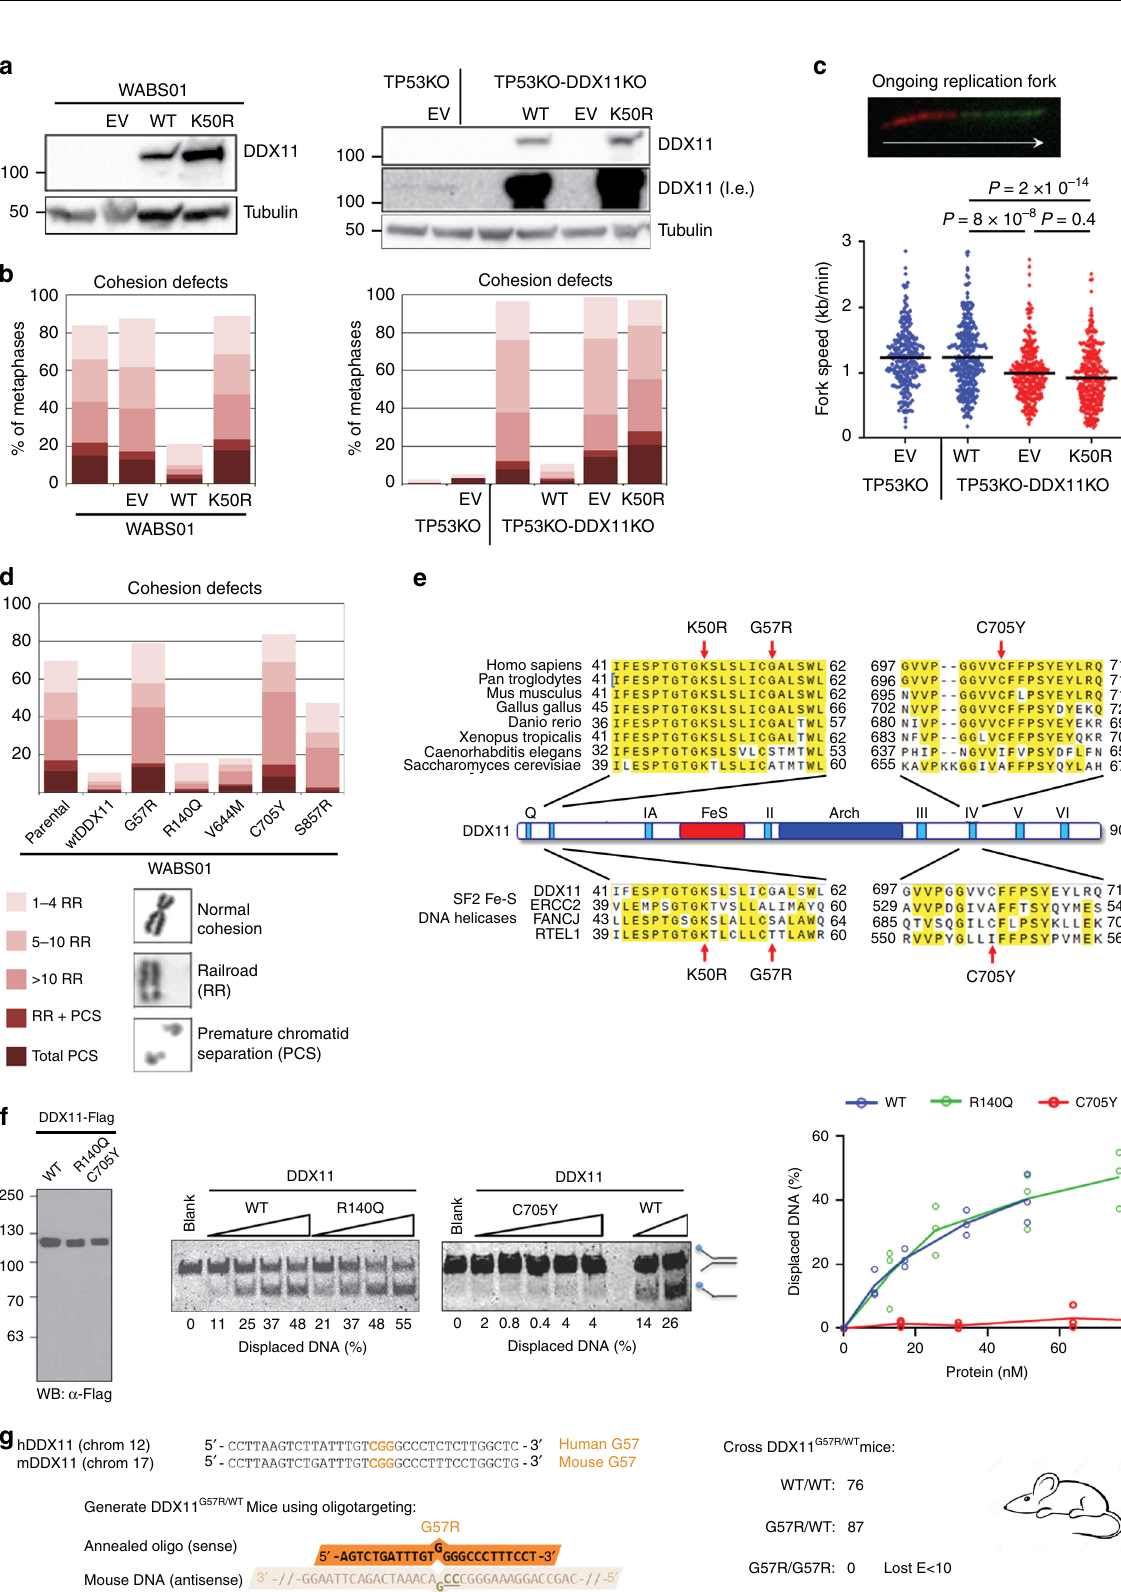
gene modi fi cation (Fig. 8g). Intercrossing of these mice did not yield any homozygous DDX11 G57R/G57R offspring among 87 heterozygous and 78 wild-type animals. Genotyping of prenatal stages revealed lethality before day 10 of embryonic development, indicating that the presumed helicase-dead DDX11-G57R is a